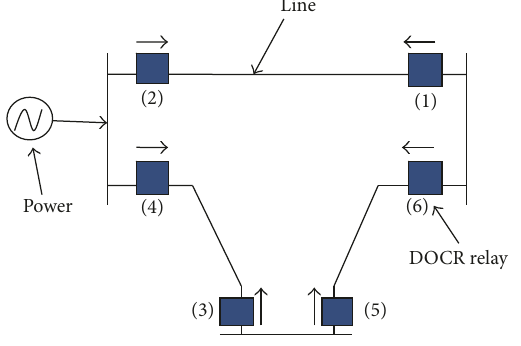
Figure 2: The 4-bus model.